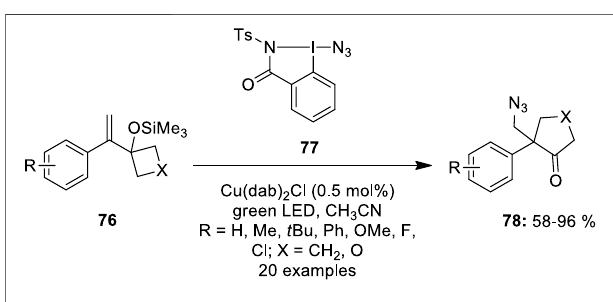
FIGURE 13 | Copper-catalyzed ring expansion of alkene-substituted cyclobutanol derivatives 76 using azidobenziodazolone 77 as an azide